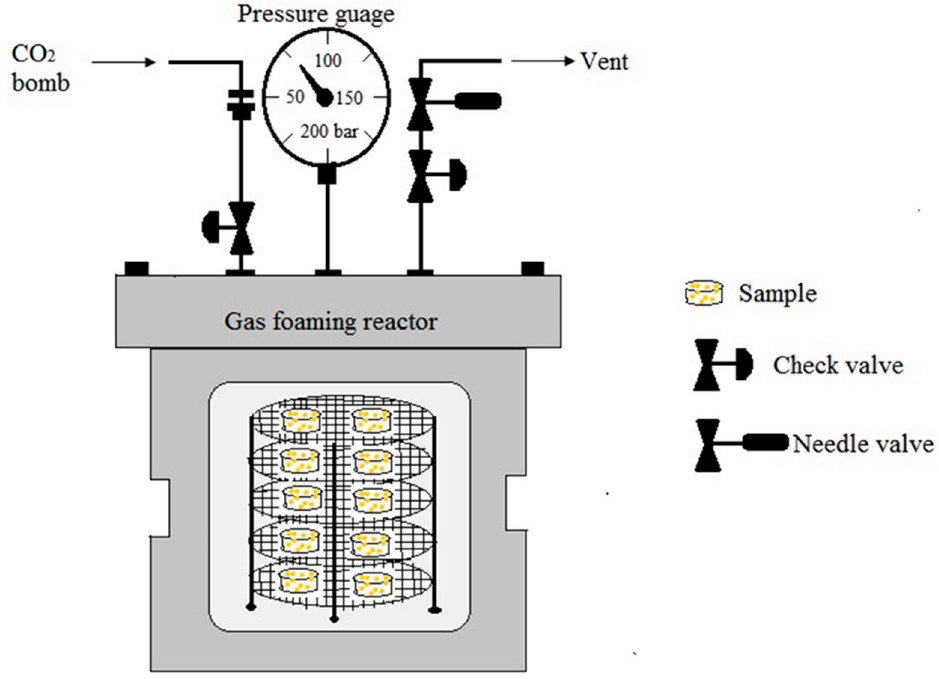
Figure 9. The schematic diagram of CO 2 gas foaming device.